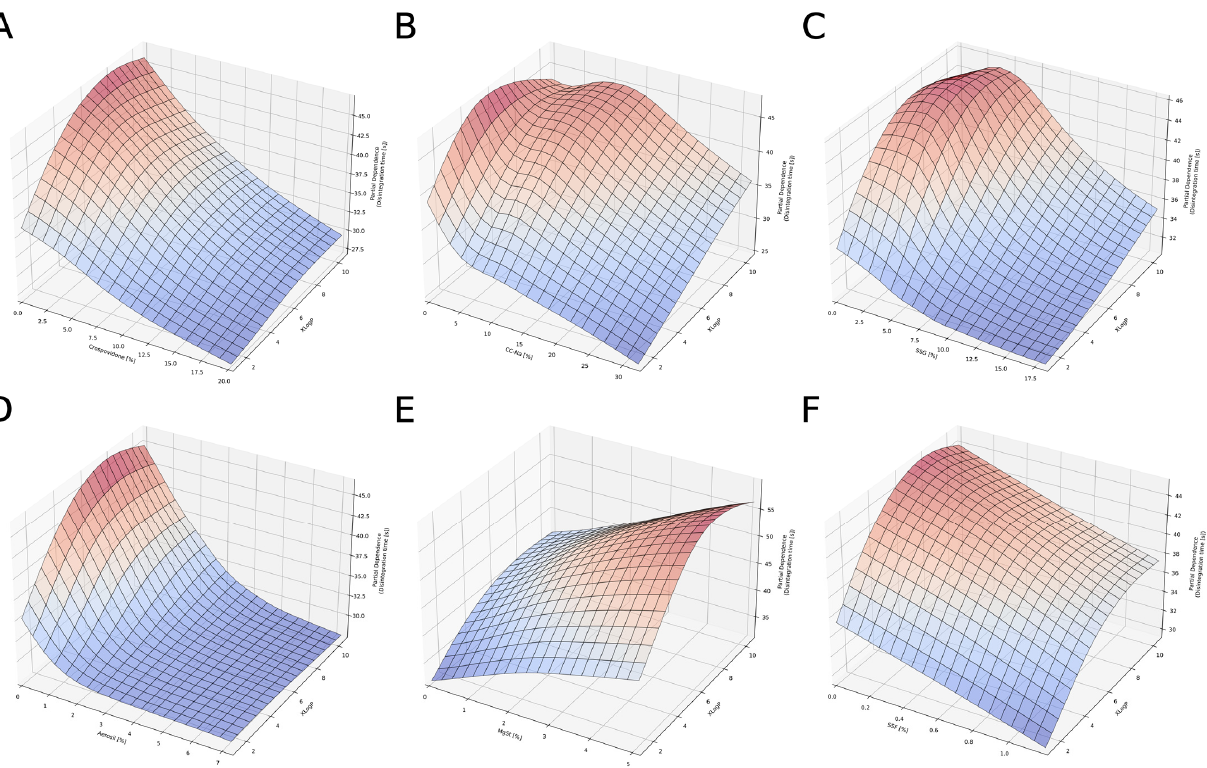
Figure 8. Partial dependency plots for XLogP vs. super-disintegrants: crospovidone ( A ), CC-Na ( B ), SSG ( C ), and lubricants: Aerosil ( D ), MgSt ( E ), SSF ( F ). XLogP, a theoretical n-octanol–water partition coefficient; SSG, sodium starch glycolate; MgSt, magnesium stearate; SSF, sodium stearyl fumarate; CC-Na, croscarmellose sodium.